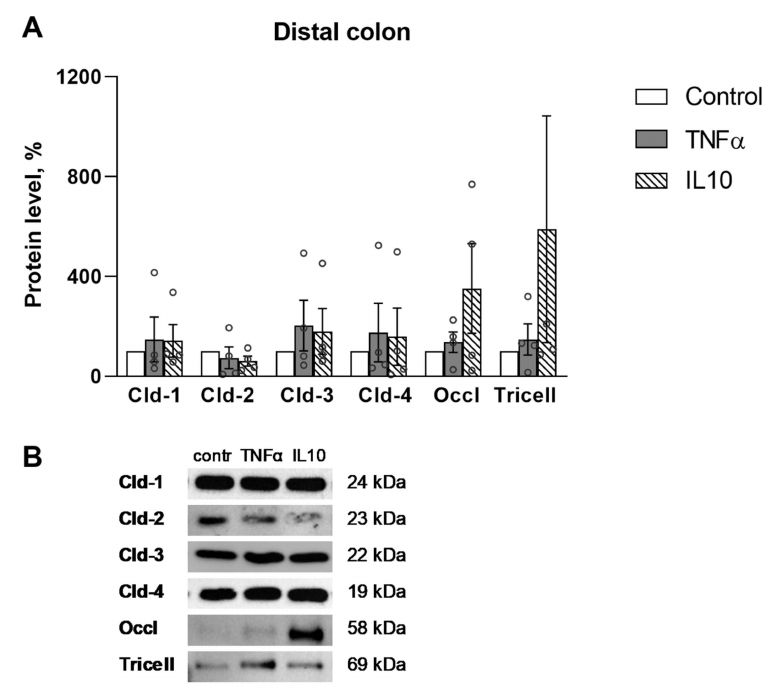
Figure 4. Western blot analysis of TJ proteins in the distal colon. ( A ) Densitometric analysis did not reveal any significant differences, p < 0.05, Mann–Whitney U-test, n for each protein = 4. The values were normalized to total protein amount. The number of symbols corresponds to the number of samples. ( B ) Representative Western blot